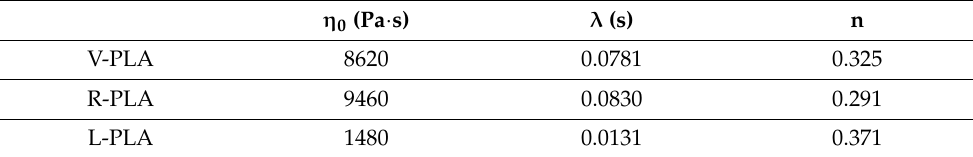
Table 5. Rheological parameters by Cross model fitting of viscosity curves. η 0 (Pa · s) λ (s) n V-PLA 8620 0.0781 0.325 R-PLA 9460 0.0830 0.291 L-PLA 1480 0.0131